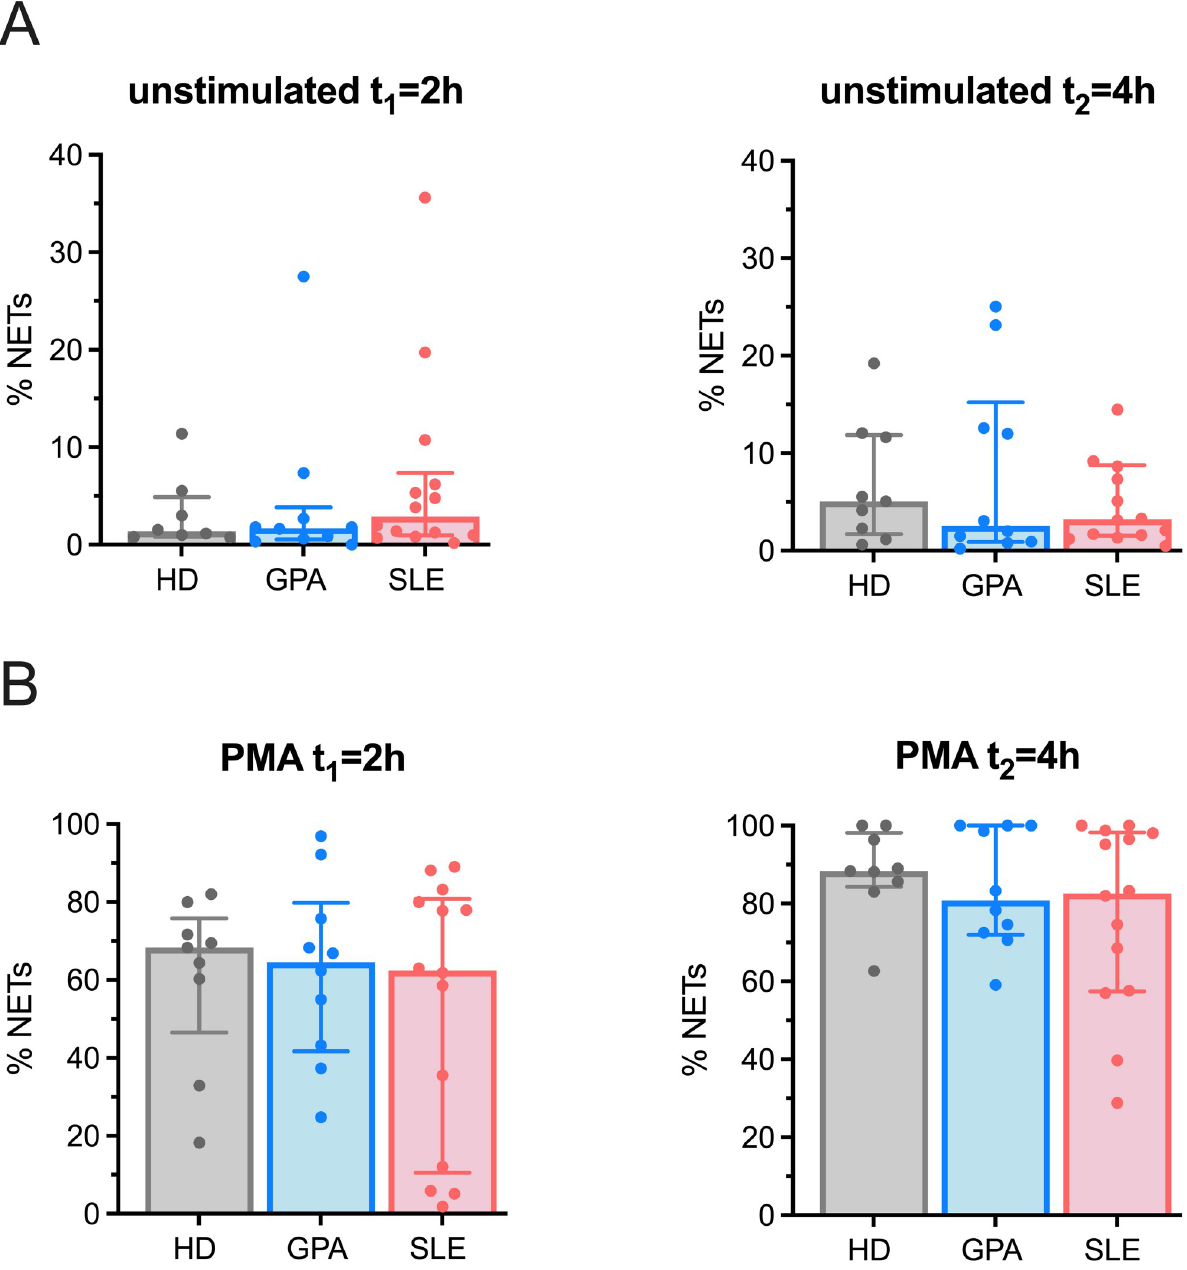
Fig 3. Quantification of NET-production in vitro . Freshly isolated NDGs were either (A) left untreated or (B) stimulated with 100nM PMA for 2 and 4 hours, respectively. The ability of NDGs to produce NETs was determined using immunofluorescence and a semiautomatic quantification in HD (n = 9), GPA (n = 10) and SLE (n = 14). Representative images are shown in S1B Fig and a detailed description of patient demographics is provided in S1 Table. Each dot represents one measured patient sample. Median values ± IQR are presented. Data were analysed by the Kruskal- Wallis-test ( α =